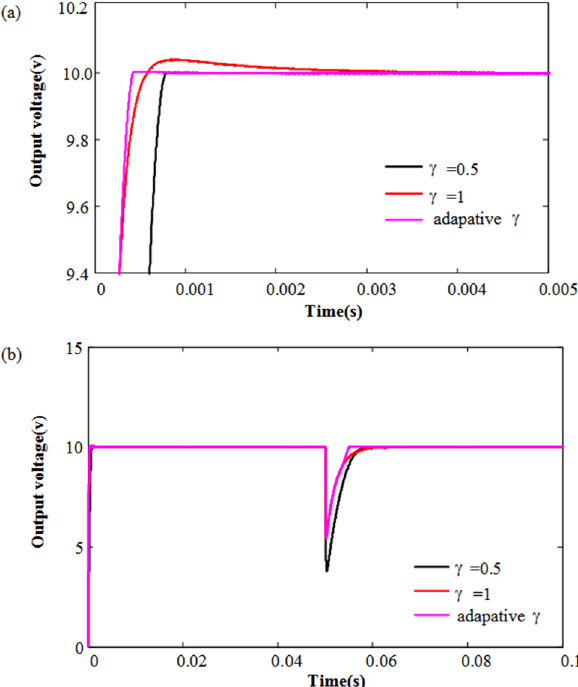
Fig 3. The output voltage dynamic response with adaptive γ . (a) The output voltagedynamic responsein start-up; (b) The output voltagedynamic responseduringload variations.